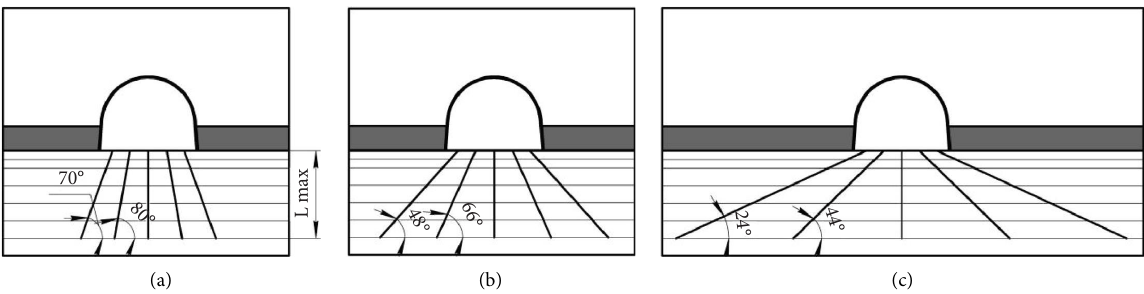
Figure 13: Te foor support schemes with diferent bolt orientations: (a) scheme I; (b) scheme II; (c) scheme